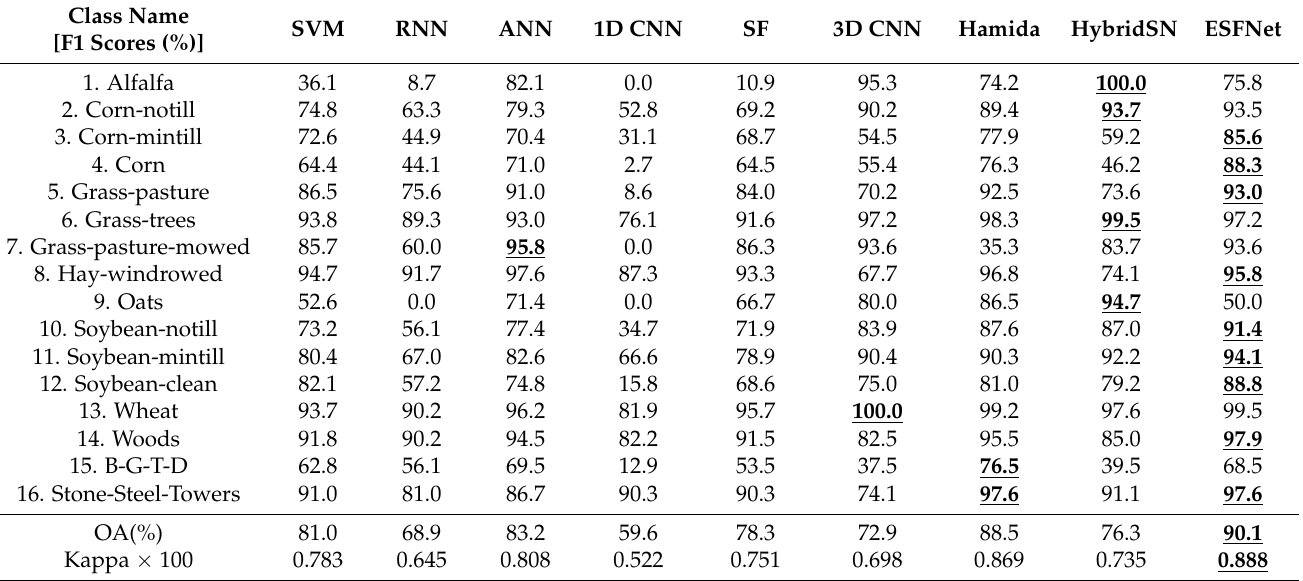
Table 5. Classification results of nine models on the Indian Pines dataset.